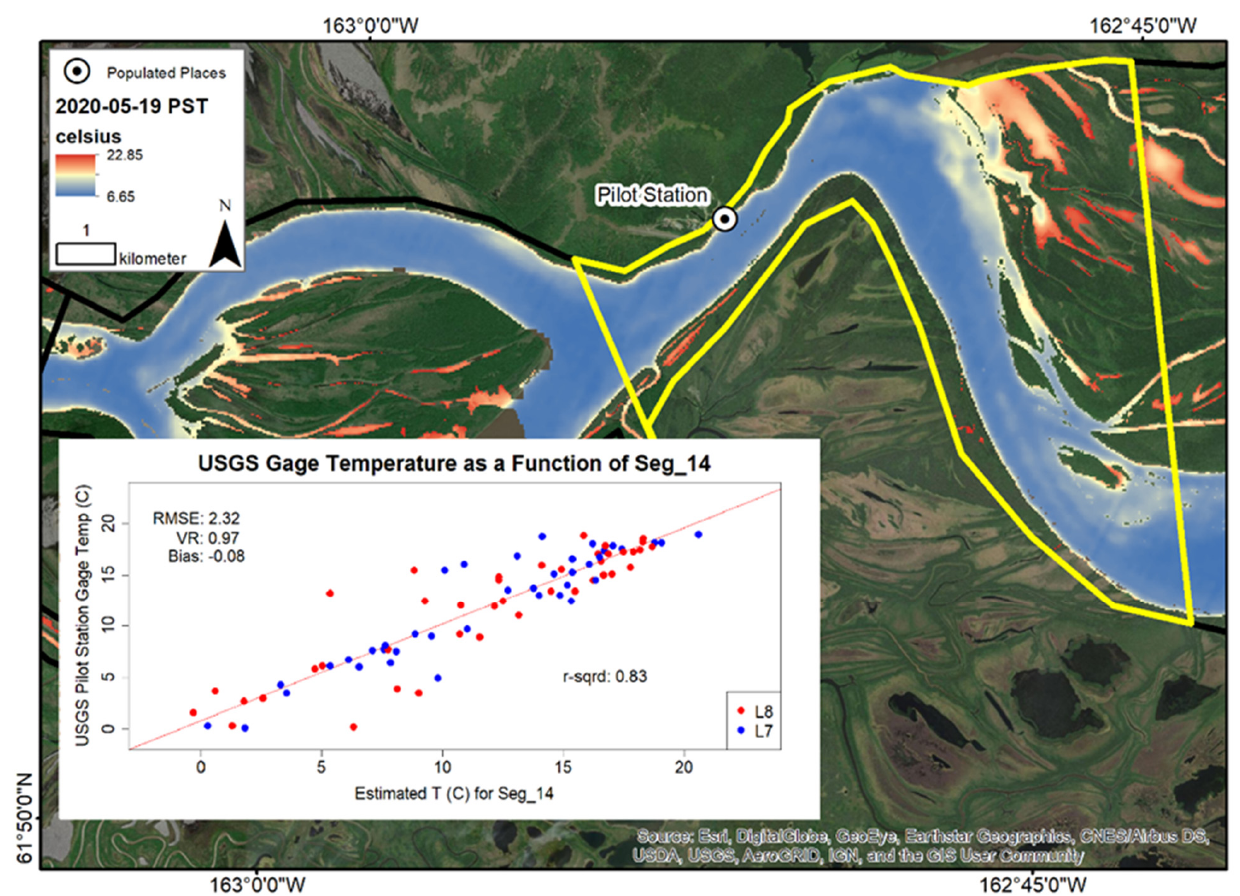
Figure A12. The Yukon River enters segment 14 flowing in a northwest direction, then making a hairpin turn before flowing southwest. The village of Pilot Station and the USGS gaging station are located in this segment. Pilot Station is located at a terminal end of the Adreafsky Mountains. Aside from this stretch of the river, the remaining shorelines are made up of lowlands and floodplains. The Chuilnak River enters the Yukon River upstream of Pilot Station. At high water stages, backwater features develop adjacent to the river as depicted in the above scene. The correlation between estimated and measured water temperature is good (RMSE = 2.32 °C, r 2 = 0.827).